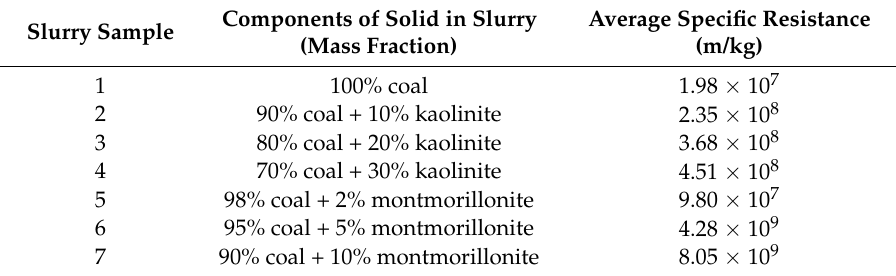
Table 3. Average specific resistance of different slurry samples.